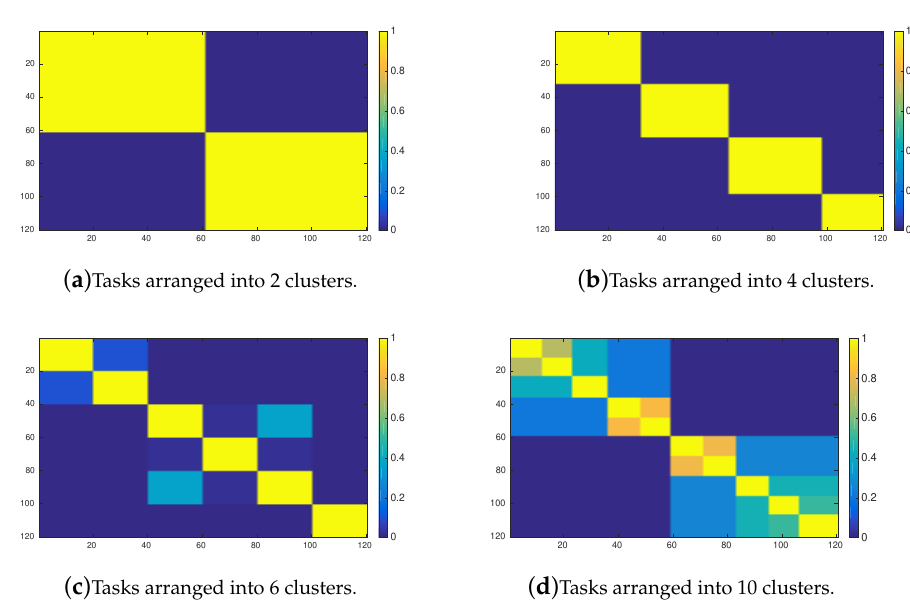
Figure 13. Possibilistic transition matrix, induced by the YPRF, powered after reaching a stationary possibilistic distribution ( P τ ) for the 120 tasks, nTH = 4 and different number of clusters of